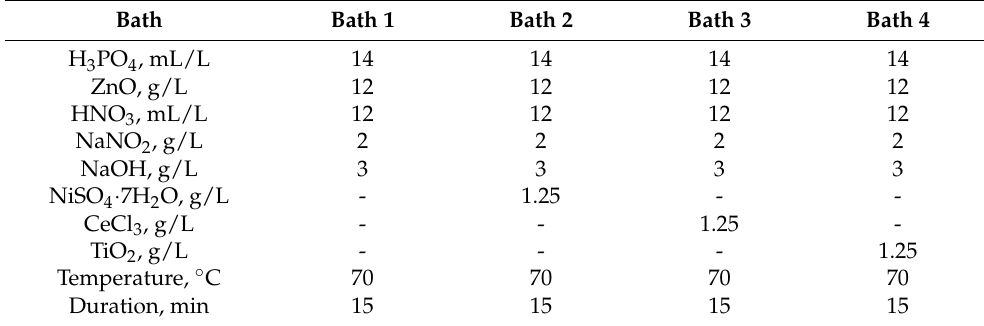
Table 2. Bath compositions and deposition parameters.